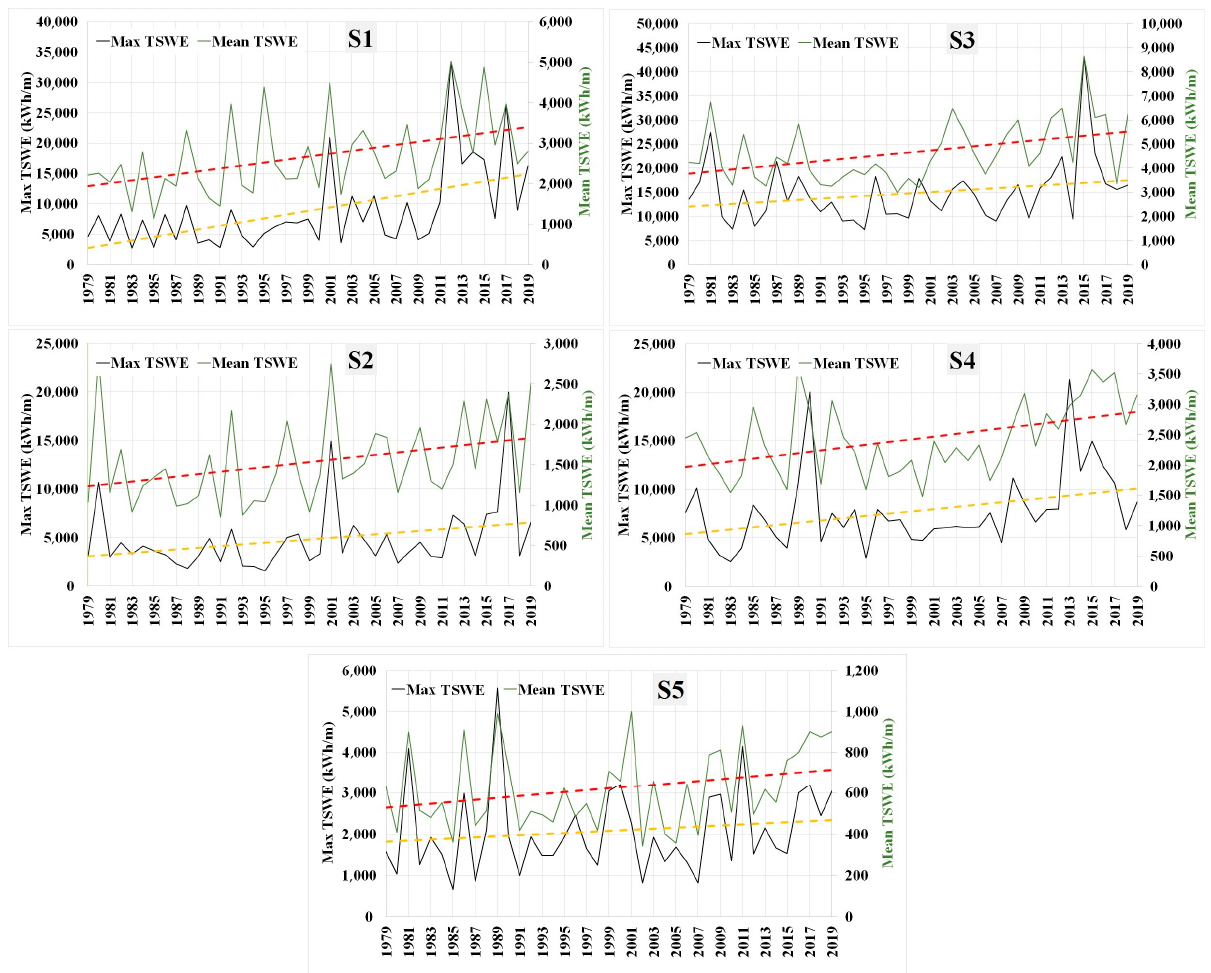
Figure 8. Time series plots of annual average and maximum TSWE between 1979 and 2019 in five different locations of the Mediterranean Sea that have experienced the significant trend during this period. The dashed line shows the linear trend of each time series. The discontinued line illustrates the estimated Theil–Sen slope adjusted to the corresponding time series plot.